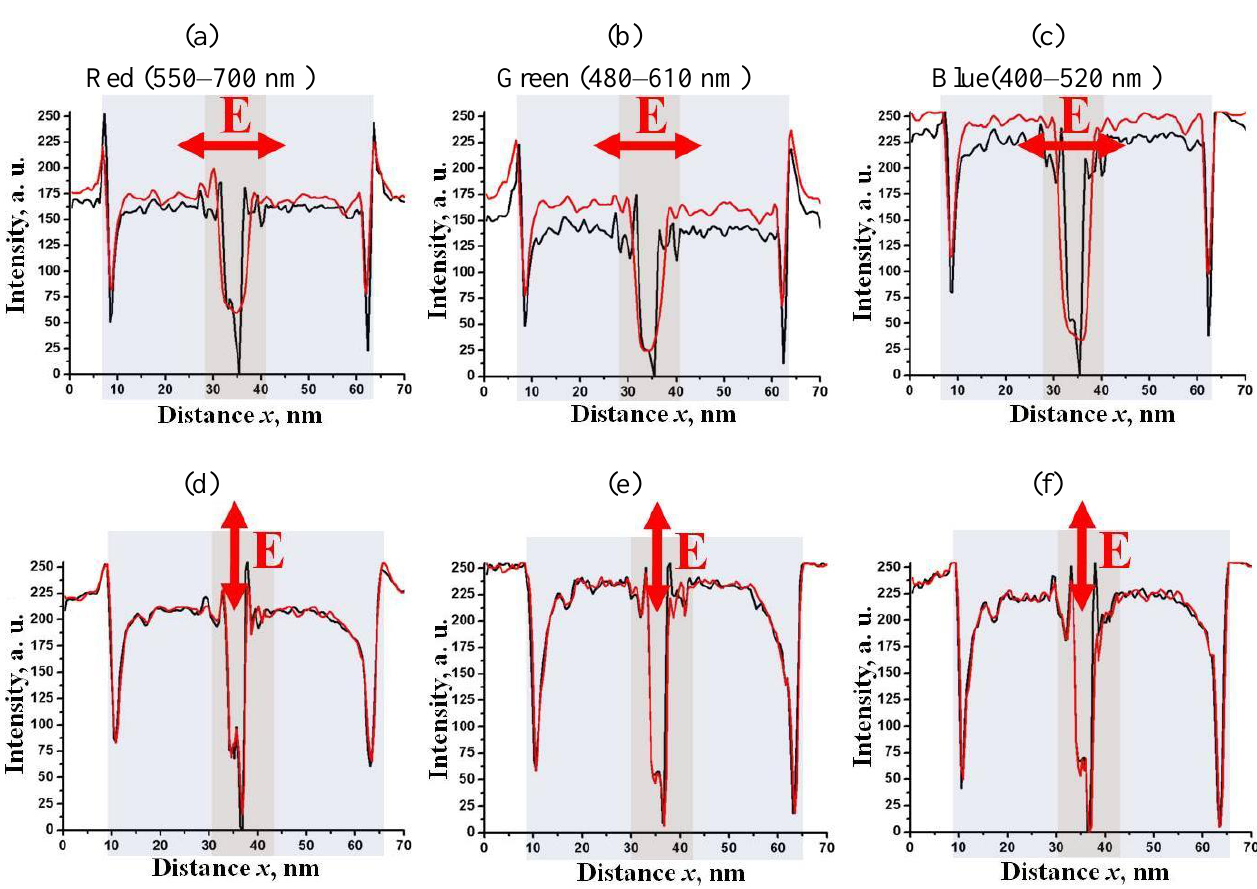
Figure 12. Electric field-induced redistribution of “long/thin” Au NRs changes the profiles of light transmission through the capillary for the light polarization perpendicular to the capillary (a) , (b) , (c) , but not for E parallel to the capillary (d) , (e) , (f) . Black traces: the field 𝐄 is off, red traces: field 𝑒